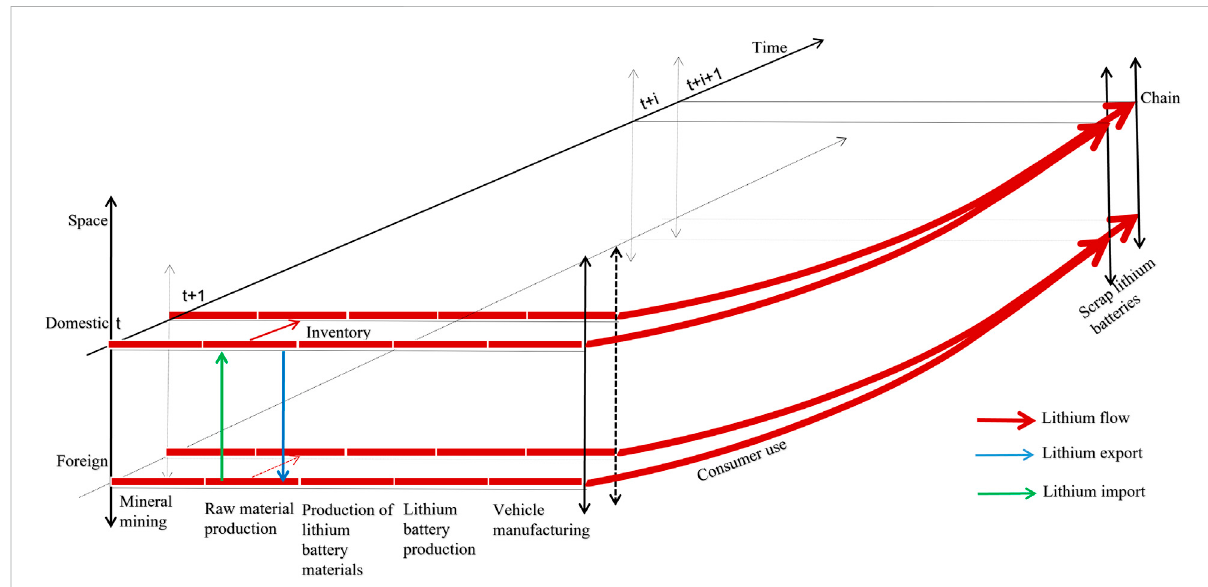
FIGURE 2 Basic framework of lithium material fl ow in the new energy vehicle